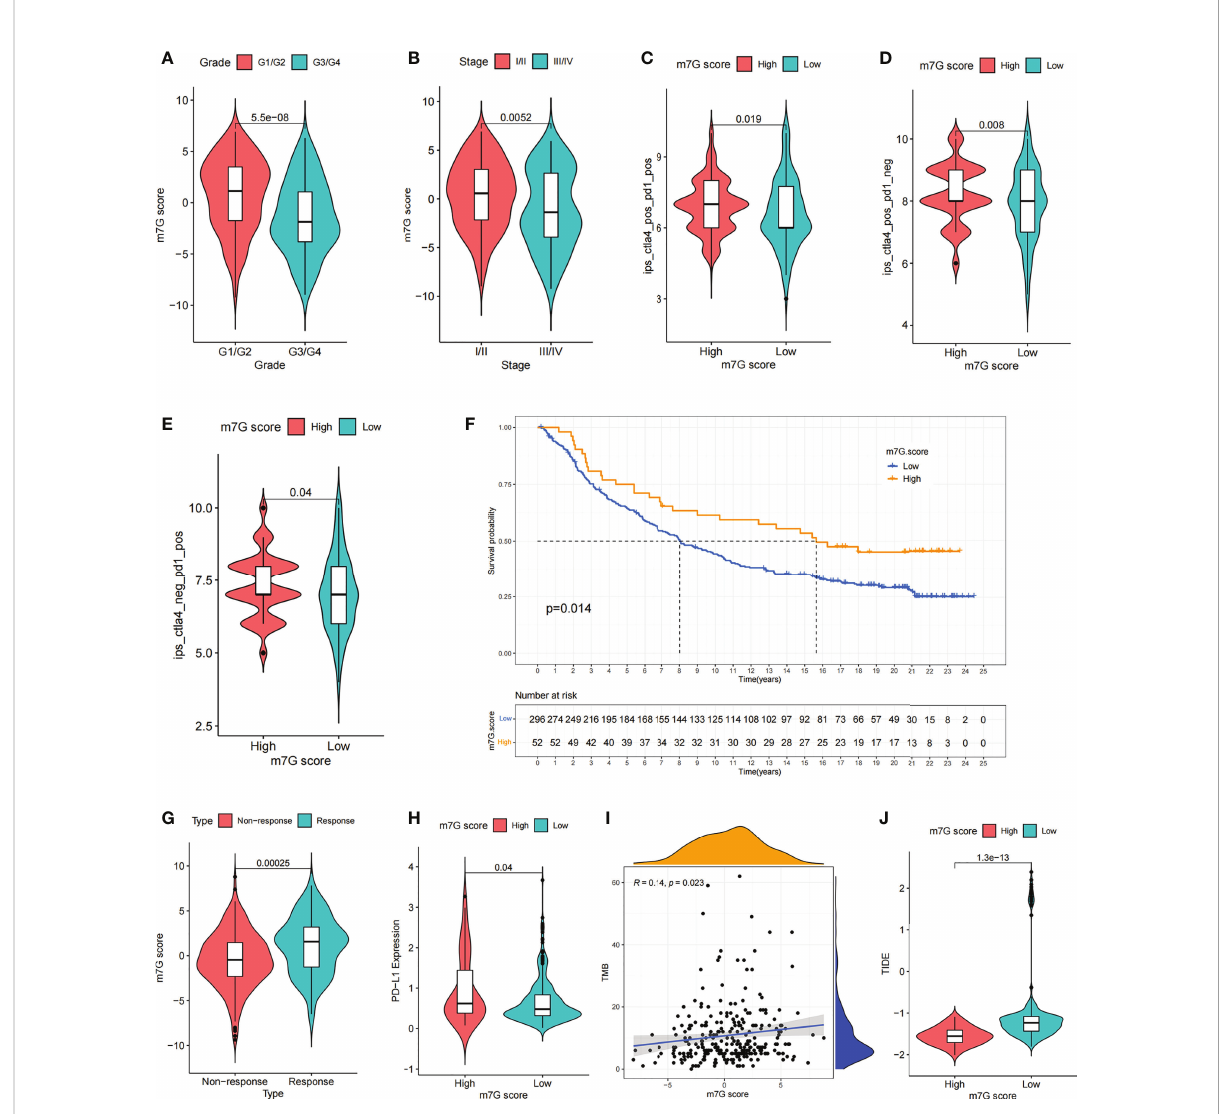
FIGURE 8 The m 7 G score predicts immunotherapeutic bene fi ts. (A, B) Comparison of differences in m 7 G scores between tumor grade subgroups (A) and TME stage subgroups (B) . (C – E) Comparison of differences in IPS scores between high and low m 7 G score subgroups. (F) Comparison of m 7 G score between different anti-PD-L1 treatment response subgroups in IMvigor210 cohort. (G) Survival curves for high and low m 7 G score subgroups of patients in IMvigor210 cohort. P< 0. 05. (H) Comparison of PD-L1 expression between high and low m 7 G score subgroups in IMvigor210 cohort. (I) m 7 G score and TMB were signi fi cantly and positively correlated in IMvigor210 cohort. (J) Comparison of differences in TIDE scores between high and low m 7 G score subgroups in IMvigor210